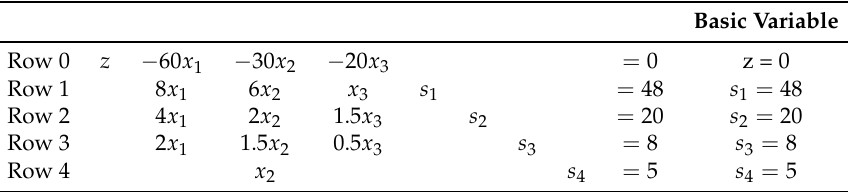
Table 1. Example of a simplex